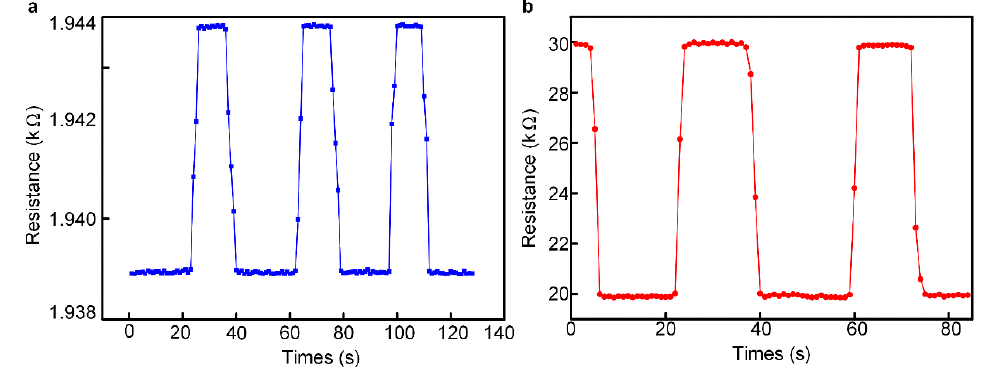
Figure 9. The dynamic response property of the tactile and pressure sensor. ( a ) The response time of the tactile sensor. ( b ) The response time of the pressure sensor.